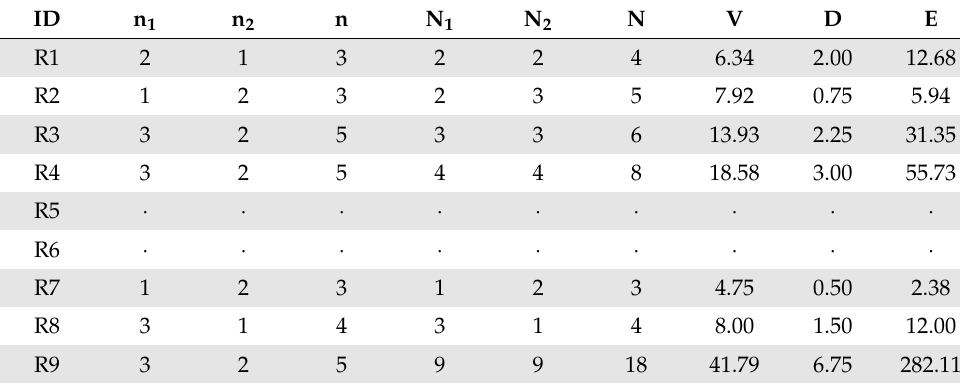
Table A2. Metrics calculations for BPMN-Q .